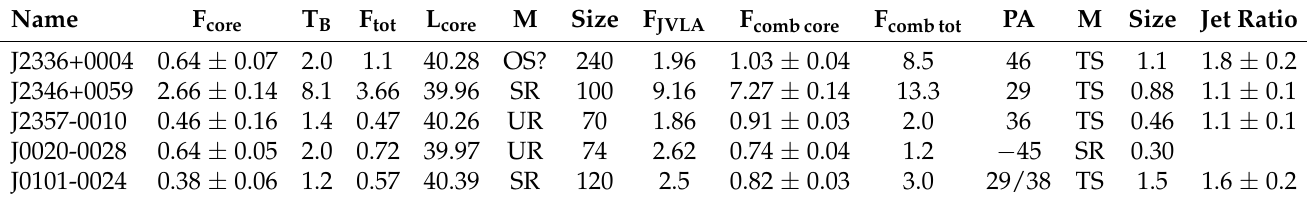
Figure 1. The 5 GHz maps of the 5 FR 0s observed with the e MERLIN array. The filled area, shown at the bottom-left corner of the images, represents the restoring beam of the maps. Contours and beam parameters are given in Table A1. Table 2. Column description: (1) name; (2)–(5) core peak flux density (mJy beam − 1 ), core brightness temperature (units of 10 4 K), total core flux density (mJy), and its core luminosity (erg s − 1 ) from e MERLIN maps at 5 GHz; (6)–(7) radio morphology (TS, two-sided; OS, one-sided; SR, slightly resolved; UR, unresolved) and size (pc); (8) core peak flux density (mJy beam − 1 ) from the JVLA maps [64]; (9)–(10) core peak flux density (mJy beam − 1 ) and total emissions from the combined JVLA– e MERLIN maps; (11)–(13) PA (degree), radio morphology, and size (kpc); (14) jet